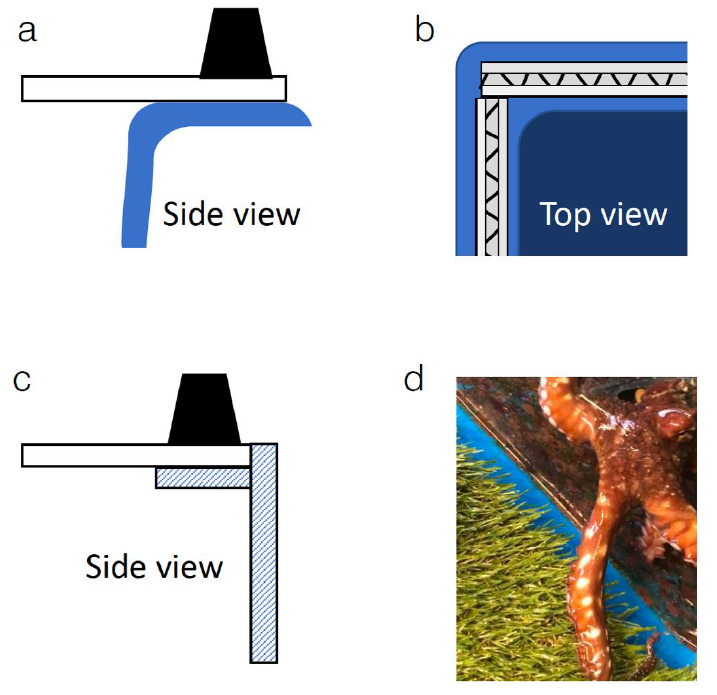
Figure 2. ( a ) Side view of Tank 1A closure — A custom cut plexiglass lid was affixed and weighed down onto the outward facing rim with multiple weights. In some cases, additional clamps were used. ( b ) Top view of Tank 1B closure — netting was secured over the top of the tank to a fixed rail attached to the outward facing rim. Octopuses pushed the net up out of the rail specifically in the corners. ( c ) Side view of Type 2 tank closure — A custom cut plexiglass lid was affixed to the sunken inner facing rim. ( d ) Type 3 tanks were lined with artificial grass. The octopus suckers do not adhere to this texture. As long as no smooth surface outside the tank can be reached by the arms, the octopus could not pull itself out.